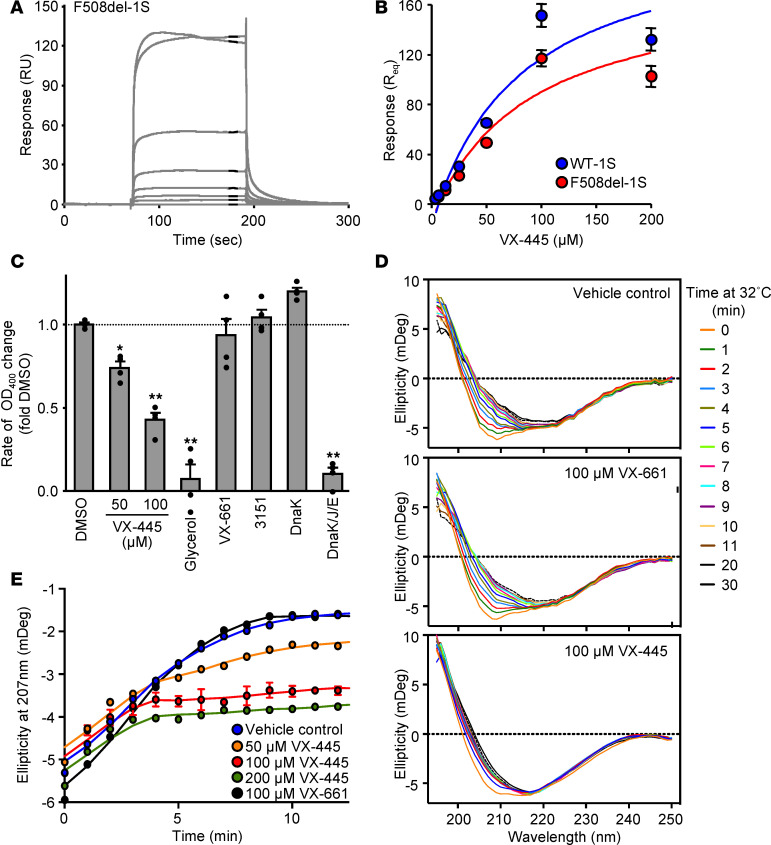
VX-445 binds to and changes the unfolding trajectory of CFTR-NBD1.(A) Representative surface plasmon resonance (SPR) sensorgram for the binding of VX-445 (0–200 μM) to immobilized F508del–NBD1-1S. (B) Binding isotherms for VX-445 binding to immobilized F508del–NBD1-1S or WT–NBD1-1S as determined by SPR (n = 3). Curve fitting was performed as described in Methods. (C) Aggregation rates observed in NBD1 aggregation assays between 30 and 50 minutes for the different compounds were normalized by the rate observed for F508del–NBD1-1S in 1% DMSO (n = 4). Compound/chaperone concentrations were 50 or 100 μM VX-445, 10% glycerol, 100 μM VX-661, 100 μM 3151, 10 μM DnaK, or DnaK-DnaJ-GrpE at 10, 2, and 10 μM, respectively. (D) Protein secondary structure stability was studied by far-UV CD spectra of F508del–NBD1-1S. CD scans between 250 and 195 nm were taken every minute at 32°C in the presence of vehicle control (1% 1,4-Dioxane), 100 μM VX-661, or 100 μM VX-445. CD scans obtained at different time intervals of 1 representative experiment were overlaid. (E) Quantification of the ellipticity values (in mDeg) observed at 207 nm. Values were plotted as a function of time in the presence of vehicle control (1% 1,4-Dioxane); 50, 100, or 200 μM VX-445; or 100 μM VX-661 (n = 2–3). Continuous lines were derived by 4-point smooth iteration. Data in B, C, and E are means ± SEM of the indicated number of independent experiments. *P < 0.05, **P < 0.01 by 1-way ANOVA followed by Turkey’s post hoc test.